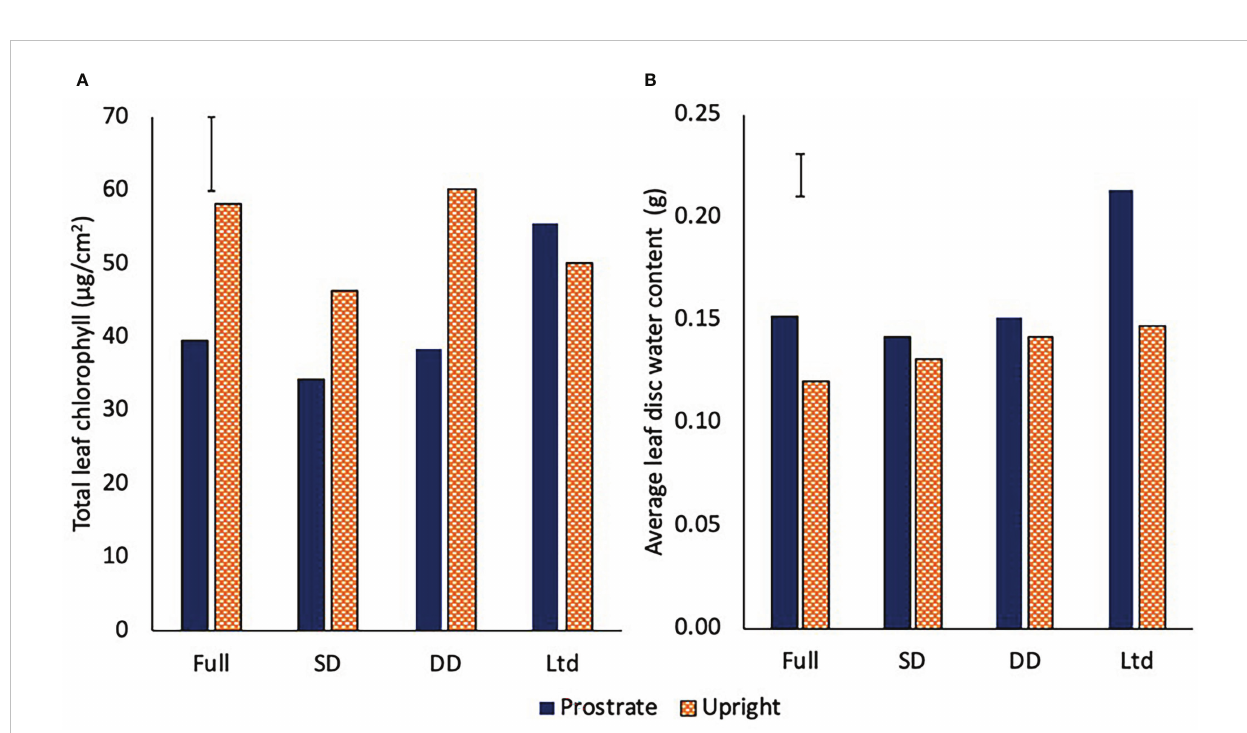
FIGURE 6 The total chlorophyll content (A) (P=0.008 DF=31 LSD=8.5) and leaf water content (B) (P=0.016 DF=31 LSD=0.021) of two sugar beet varieties with a prostrate and upright canopy grown under four different irrigation regimes, fully irrigated (Full), single drought (SD), double drought (DD) and continually water limited (Ltd). Error bar shows irrigation x variety LSD.